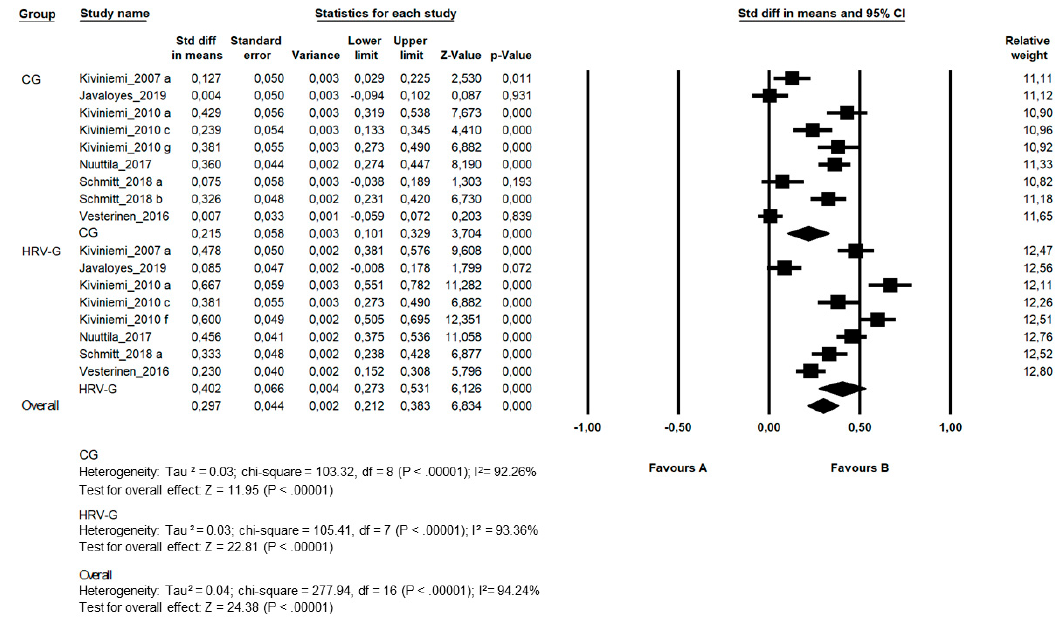
Figure 3. Standard differences in means (SDM) between post- and premeasures for VO 2max in included studies, segmented by the control group (CG) and heart-rate-variability-guided training group (HRV-G). Squares represent the SDM for each trial; the diamond represents the pooled SDM across trials; weight determines how much each individual study contributes to the pooled estimate; 95%CI, confidence